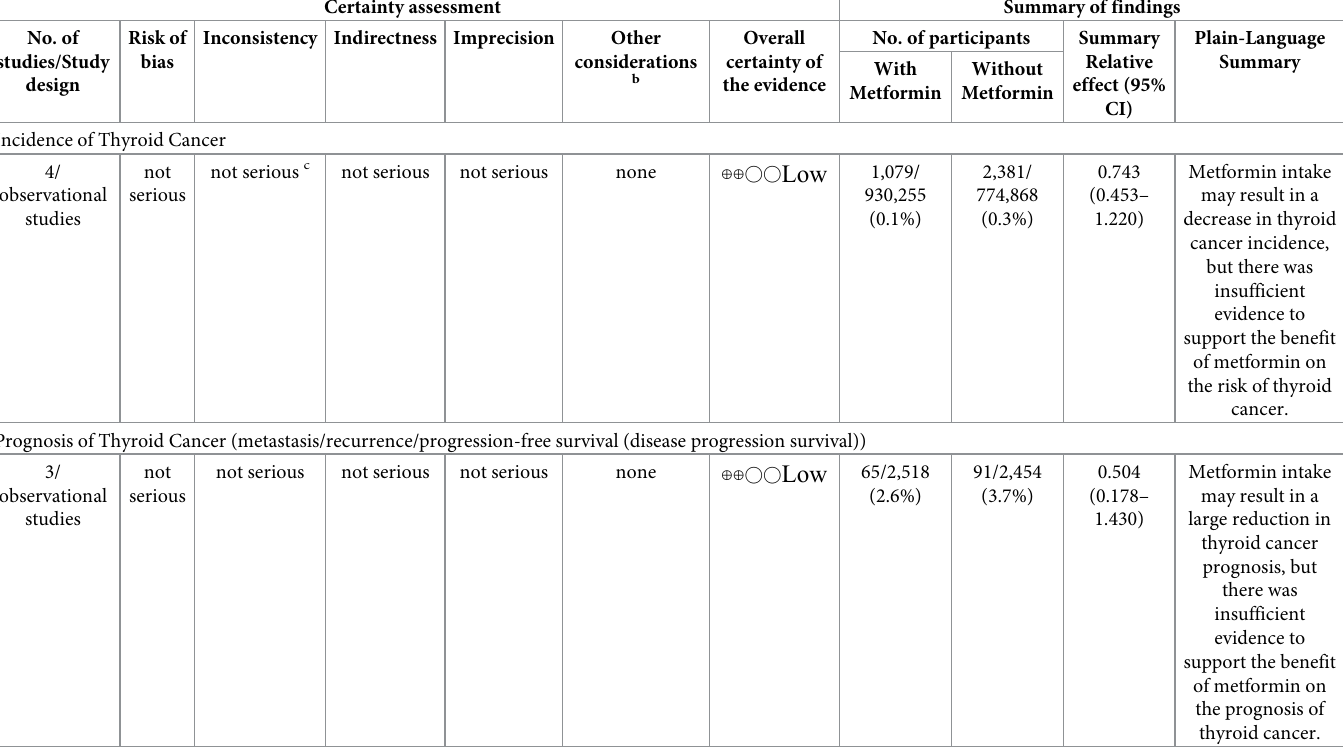
a : Table based on the Grading of Recommendations Assessment, Development and Evaluation (GRADE) approach [45], and all studies were non-randomized and evaluated using non-randomized studies of interventions (ROBINS-I) tool; b : Other considerations included magnitude of effect, dose-response effect, and impact of residual confounding and bias c : case-control and other study designs